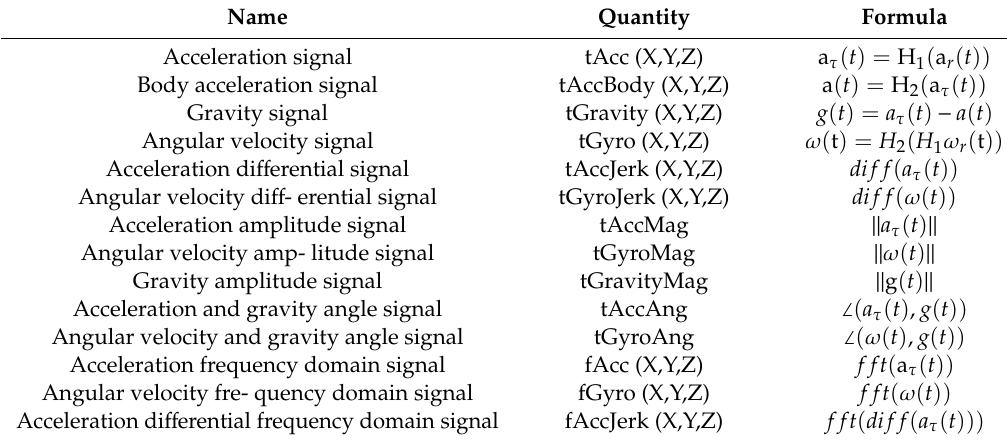
Figure 4. Angular velocity X , Y , Z axis data. Table 2. Sensor inertial signal preprocessing.